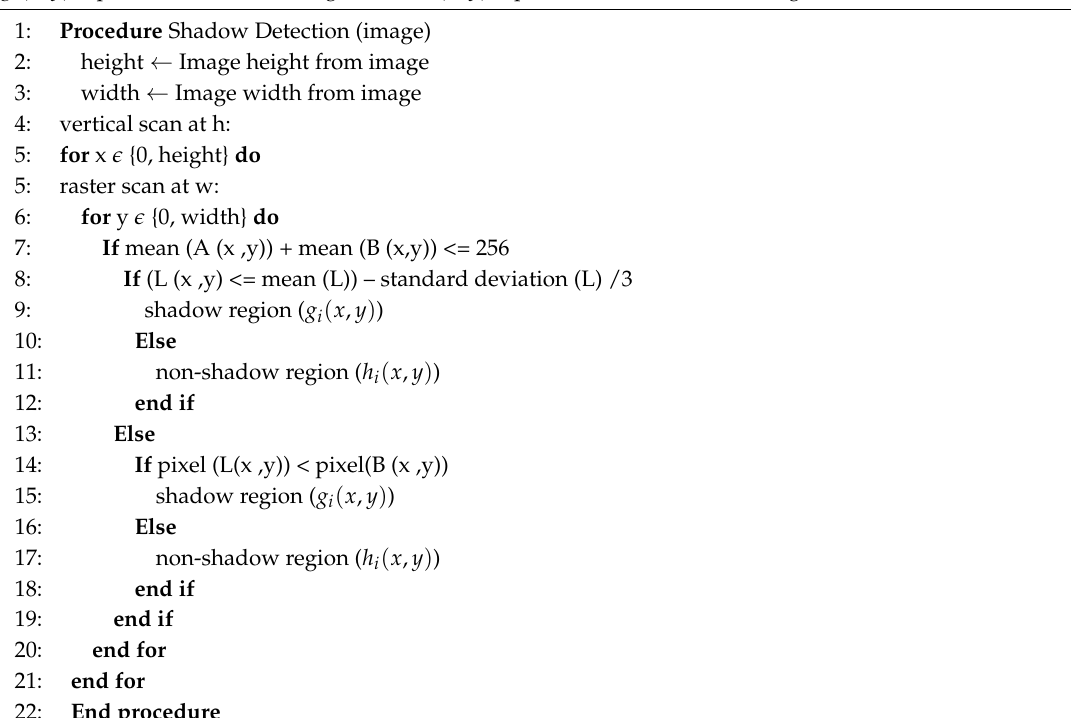
Algorithm 1 Pseudo-code description of a shadow detection. Input = UAV image. Output = Binary image ( g i ( x , y ) represents the shadow region and h i ( x , y ) represents the non-shadow region) 1: Procedure Shadow Detection